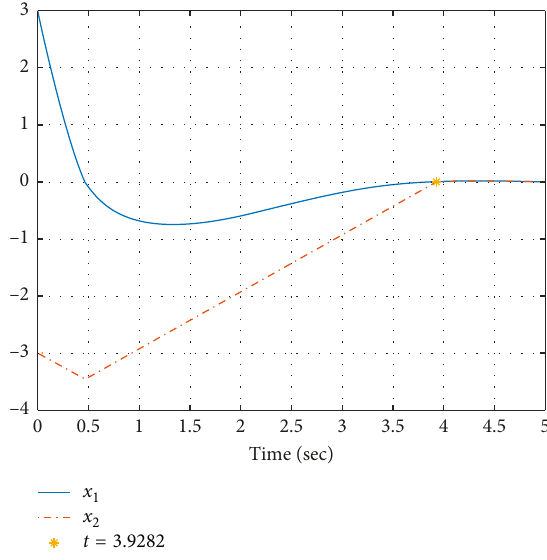
Figure 9: Finite-time convergence ( A � − ( 2/9 ) ).